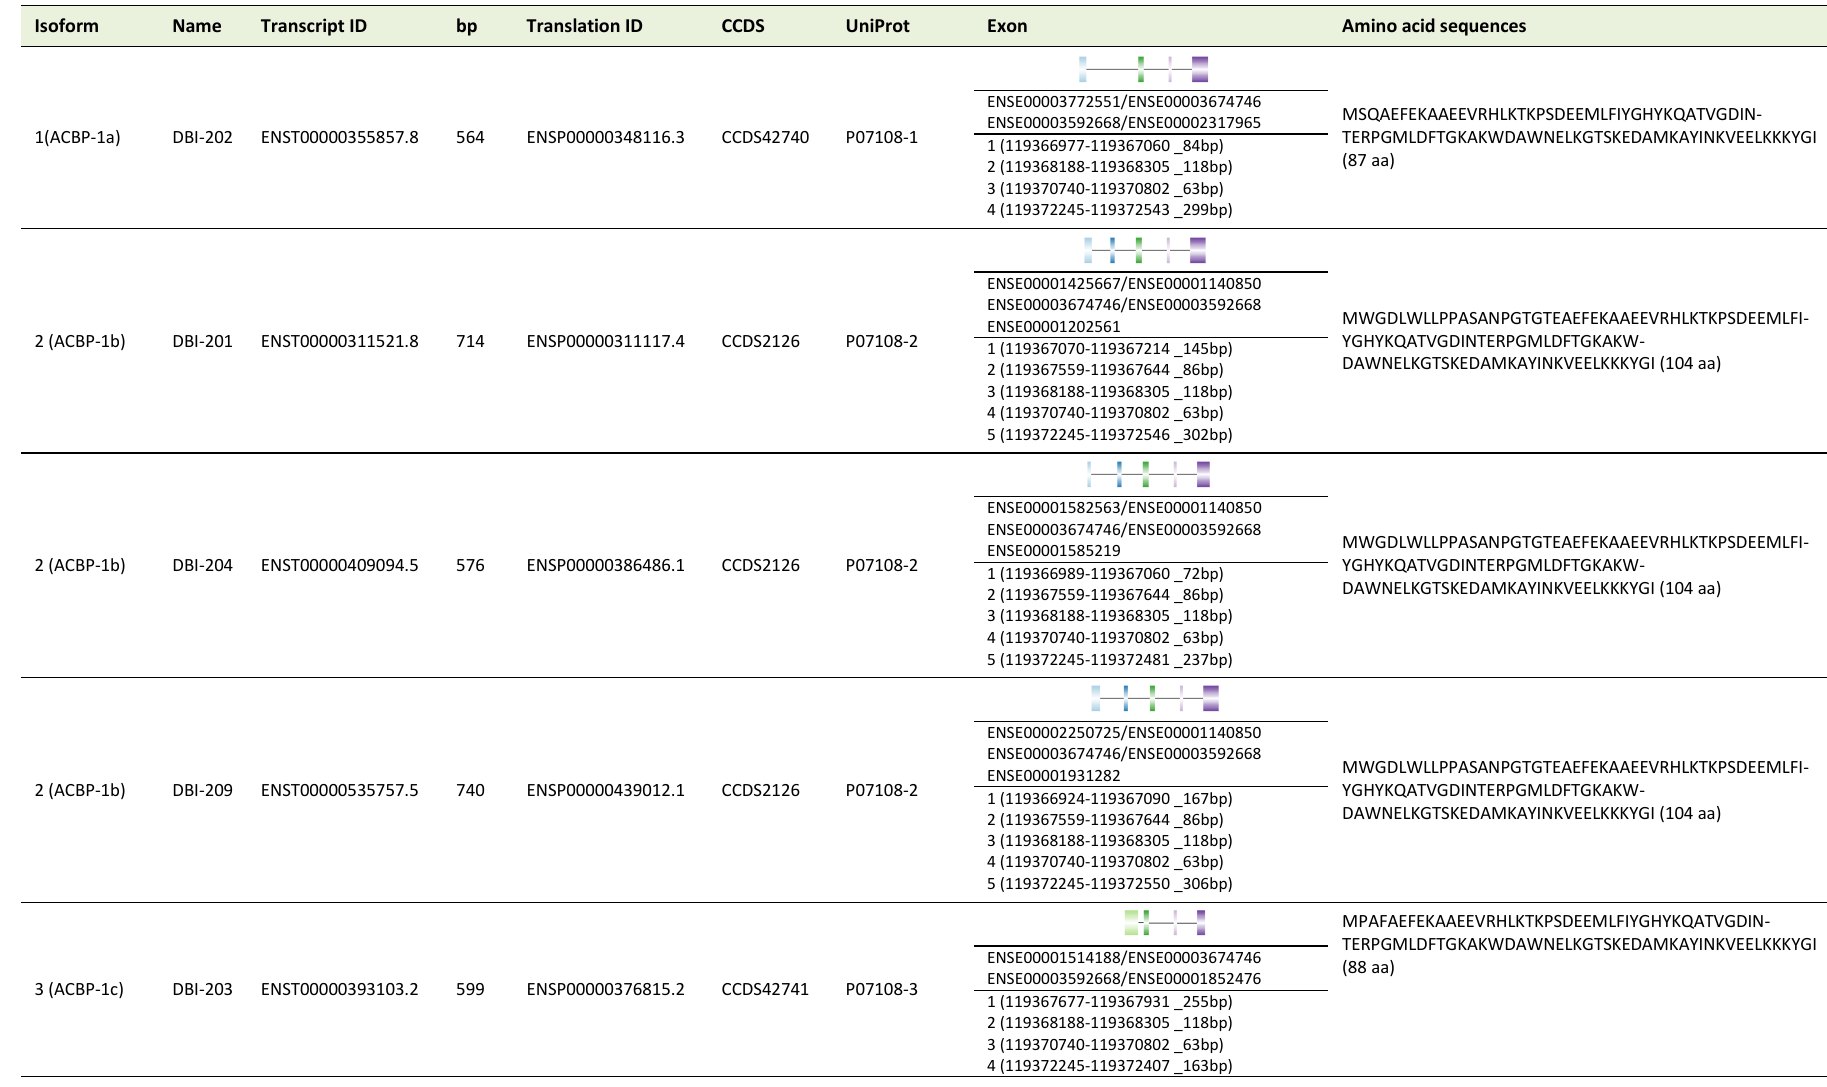
TABEL 1. Transcripts of the DBI gene and isoforms of the DBI protein